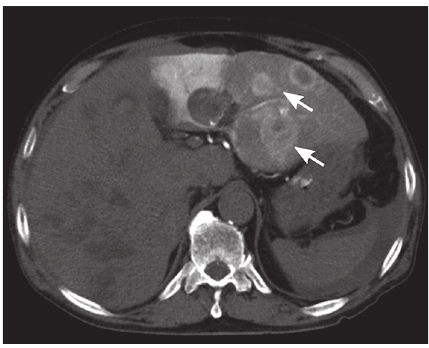
Figure 6: Arterial phase of computed tomography during left hepatic arteriography. In the left lobe of the liver, tumor stains were observed in more tumors than in the right lobe